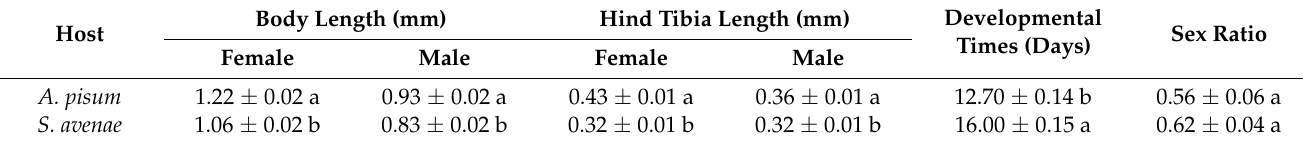
Table 1. Body length, hind tibia length, developmental times and sex ratio of A. asychis that were reared on A. pisum and S. avenae .